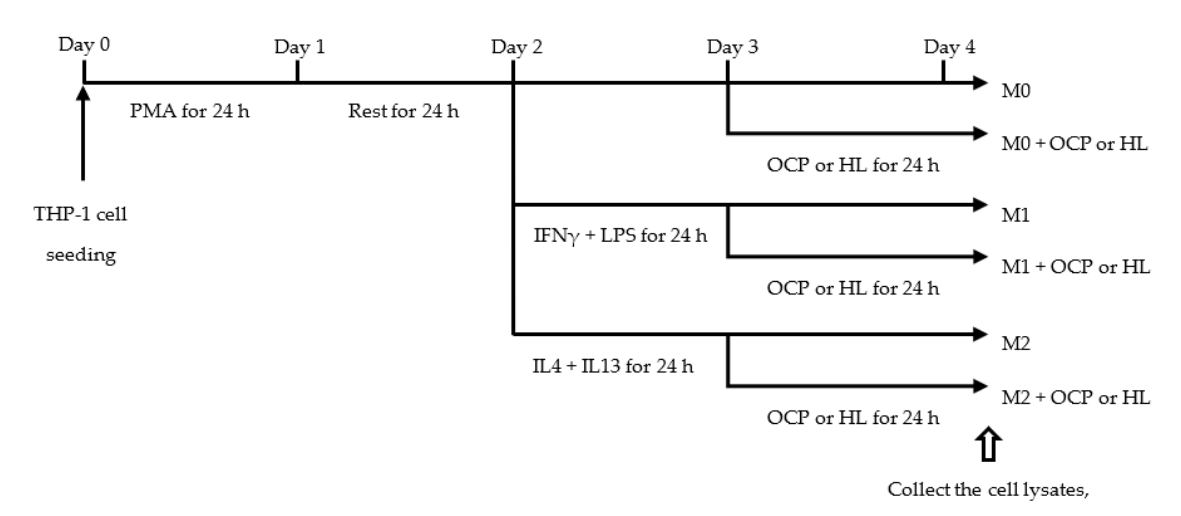
Figure 2. THP-1 cell treatment flowchart. THP-1 cells were differentiated into M0 macrophages by 24 h incubation with 100 ng/mL PMA. THP-1 derived macrophages were polarized into M1 macrophages by incubation with 20 ng/mL IFN γ and 10 pg/mL of LPS for 24 h. THP-1 derived macrophages were polarized into M2 macrophages by incubation with 20 ng/mL of recombinant human IL4 and 20 ng/mL of recombinant human IL13. Three phenotypes of THP-1 derived macrophages or RAW 264 macrophages were treated with OCP or HL granules for 24 h.